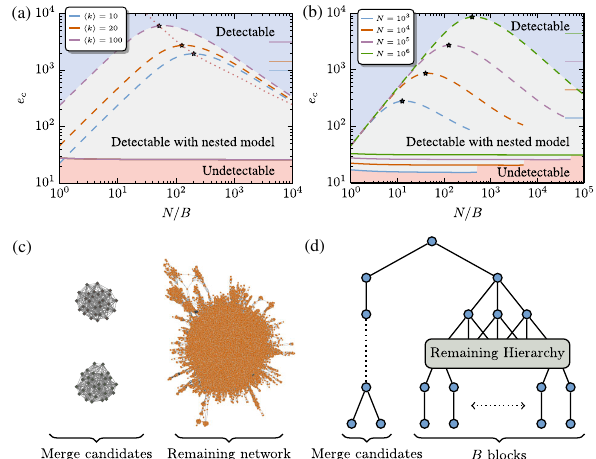
FIG. 3. Parameter region where two isolated blocks with e c = 2 internal edges and n c ¼ e c = 5 nodes are detectable as separate blocks [shown schematically in panel (c)], as a function of the average block size N=B , and depending on (a) the average degree h k i with N ¼ 10 5 and (b) the number of nodes N with h k i ¼ 20 . The dashed curves show the boundaries for the nonhierarchical block model, and the solid lines for the hierarchical variant. The line segments on the right-hand side of the plots show the detectability threshold for modularity [14], e (cid:2) c ¼ points marked with stars ( ⋆ ) correspond to the maximum value of B that is detectable in the remaining network with the nonhierarchical model, and the dotted line shows the same quantity for various h k i values (i.e., the region on the left of this curve corresponds to an overfitting of the remaining network, according to the non-hierarchical criterion). (d) The hierarchical construction used to decide if the two isolated blocks are merged together with the nested